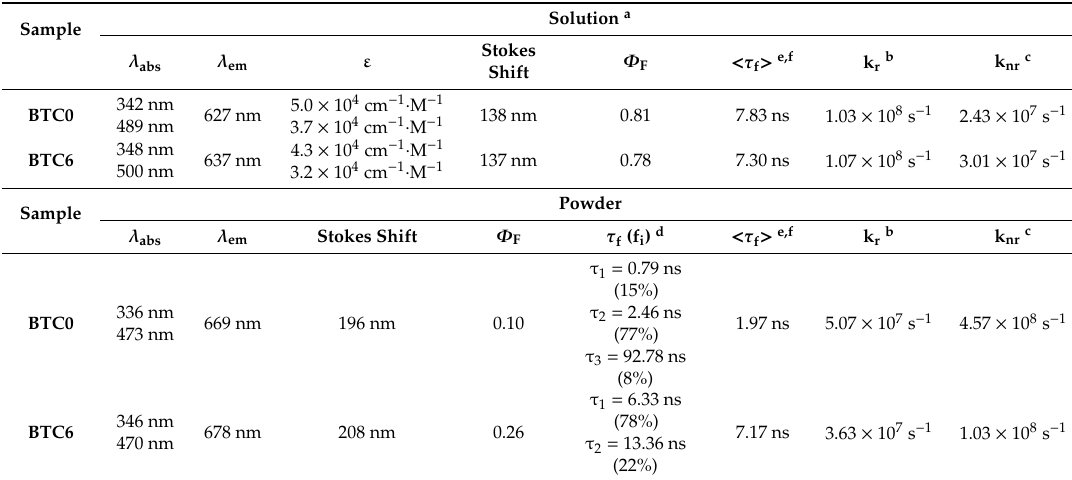
Table 1. The photophysical data of BTC0 and BTC6 in solution and powder at 298 K. Sample